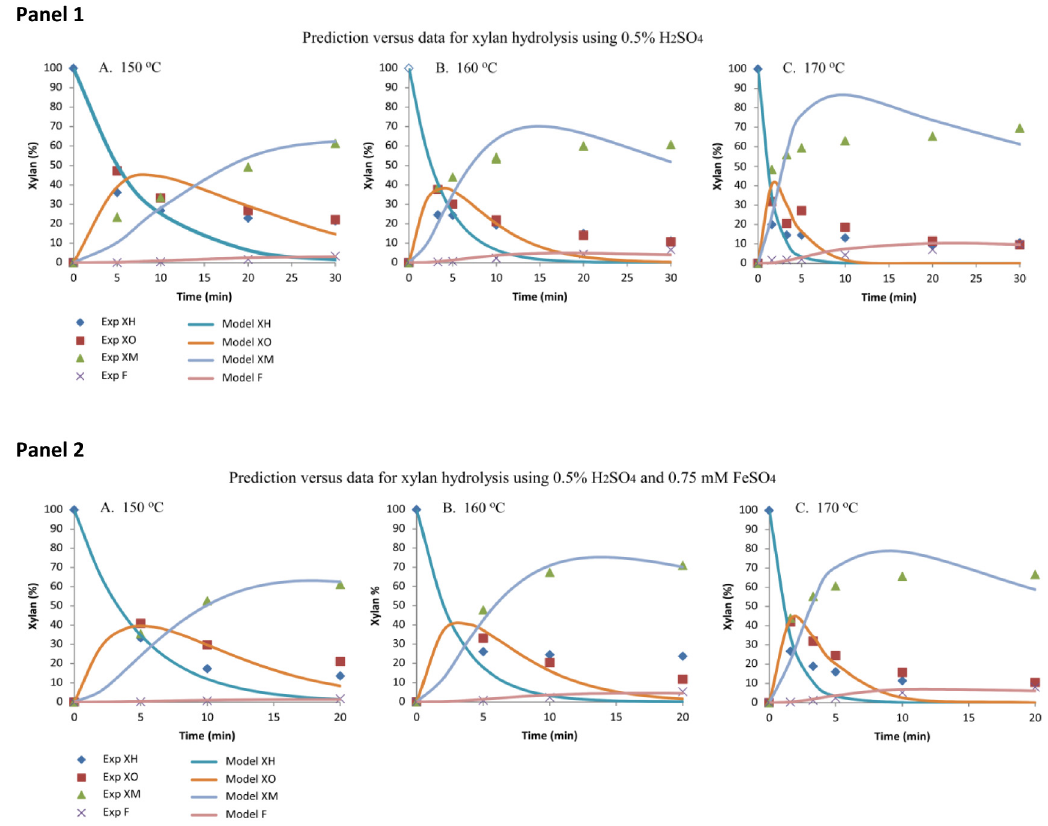
Figure 3. Best-fit model prediction and data for xylan hydrolysis using 0.5% H 2 SO 4 ( panel 1 ), and 0.5% H 2 SO 4 and 0.75 mM FeSO 4 ( panel 2 ). The modelling and experiments were for the temperature setting at ( A ) 150 °C, ( B ) 160 °C, and ( C ) 170 °C. XH = xylan in biomass, XO = xylooligomers, XM = xylose, F = furfural.